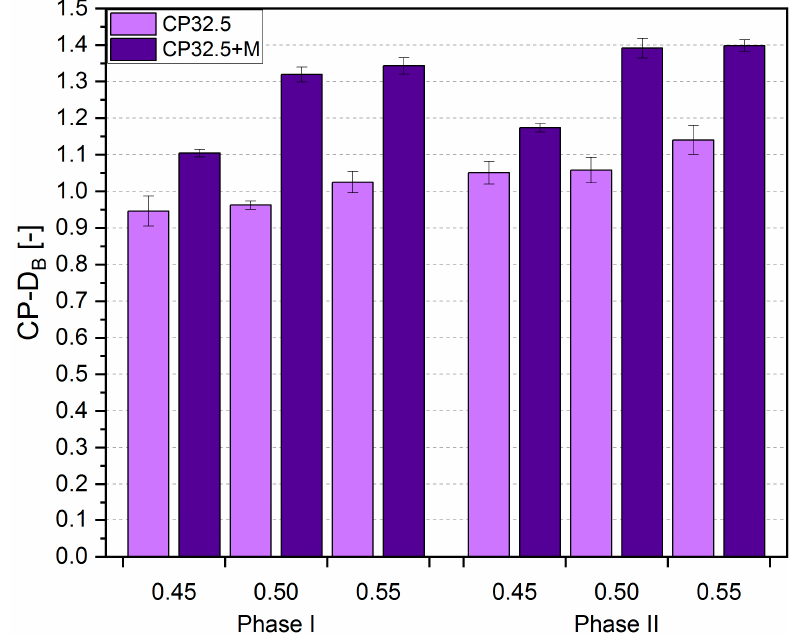
Figure 7. Results of the fractal dimension of cracking patterns ( CP-D B ) of the lime cement matrix after the first and second phase of thermal load; error bars show standard deviation.